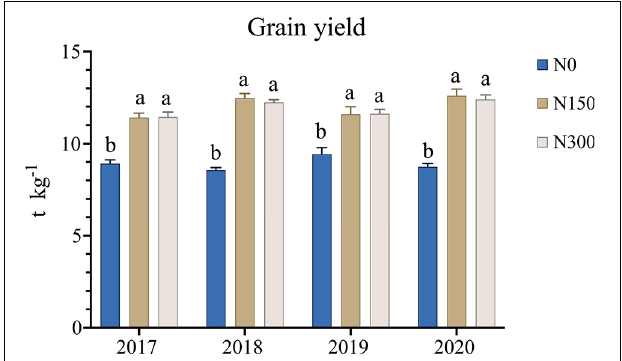
FIGURE 1 | The grain yield of Liaoxing 1 under the three N fertilizer application levels from 2017 to 2020. Different lowercase letters for one data indicate a significant differences at p <